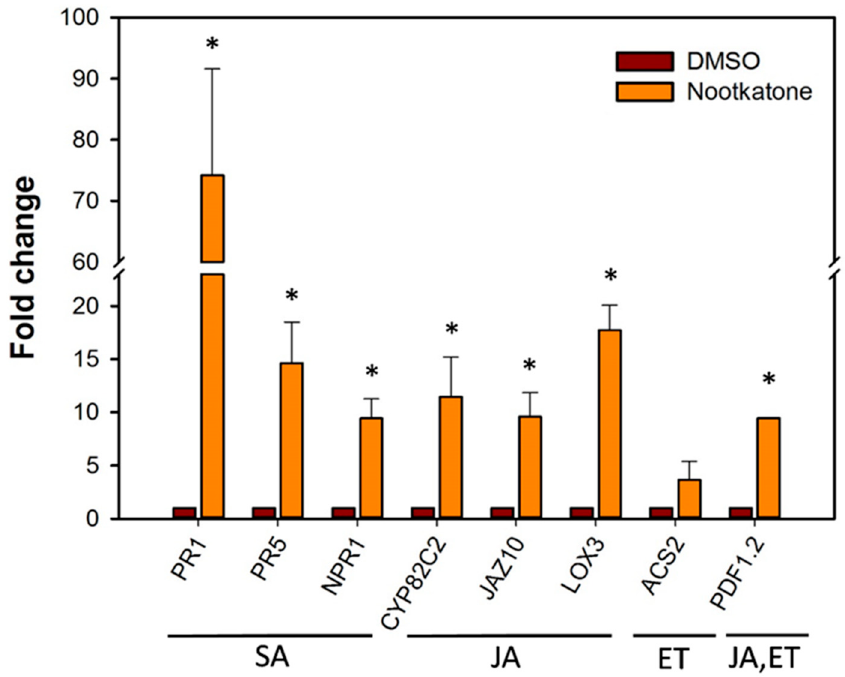
Figure 6. Relative mRNA levels of Arabidopsis thaliana defense-related genes upon nootkatone exposure quantified by using qRT-PCR. Fold change values were calculated and represent changes in mRNA levels in Arabidopsis plants cultivated on a medium mixed with 5-ppm nootkatone relative to that of Arabidopsis cultivated on a medium mixed with 0.5% DMSO as the control. Data are averages ± SE of three biologically independent experiments, each consisting of three technical replicates. A. thaliana β tubulin transcript was used as an internal control to normalize the data. The asterisk marks indicate significant differences based on a t -test ( p < 0.05). SA: salicylic acid, JA: jasmonic acid and ET: ethylene. Table 1. Sesquiterpene hydrocarbons identified in the headspace of 30-day-old Arabidopsis thaliana . No. Compound a I b I (lit.) c